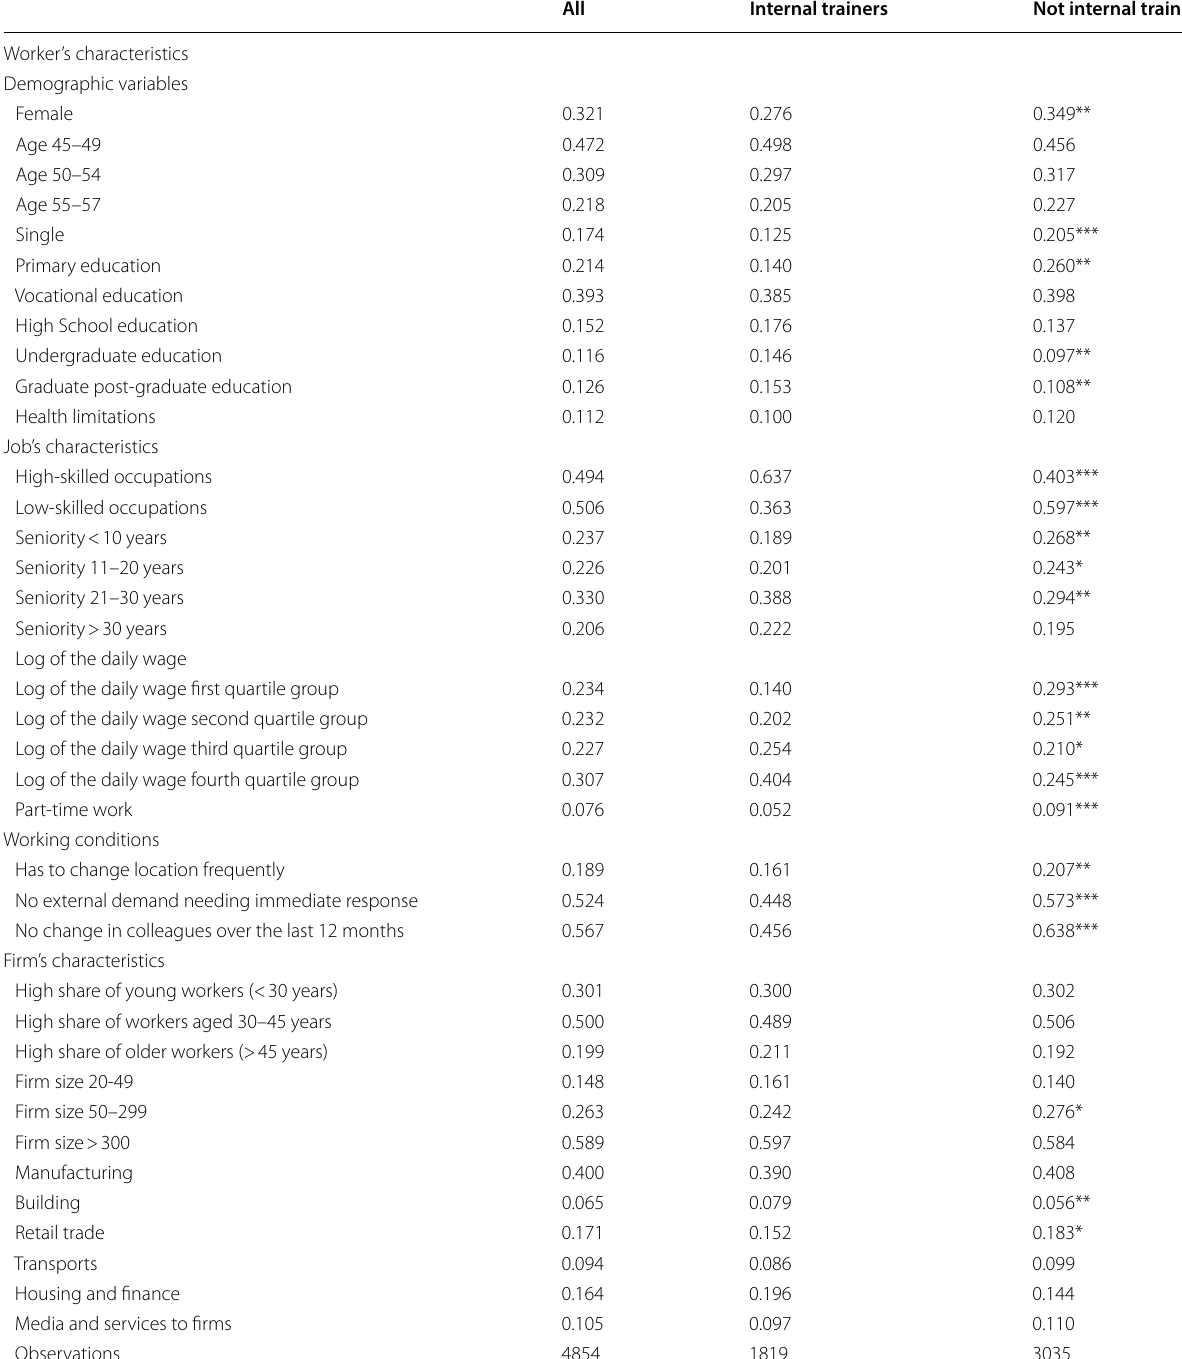
Table 2 Descriptive statistics of the